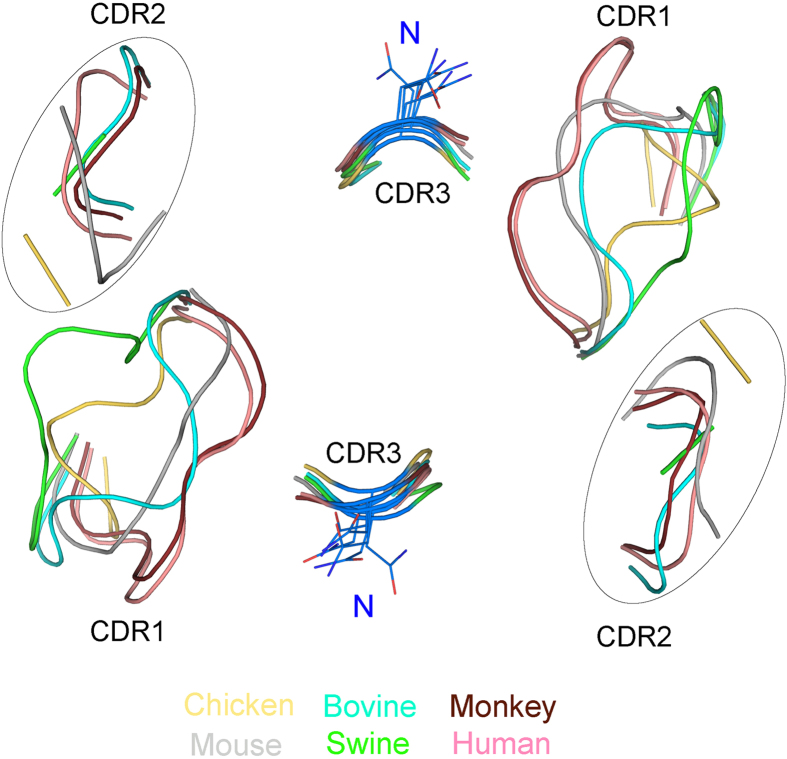
The diverse CDR1/2 and conserved CDR3 loops in CD8αα structures.The structural alignment shows the CDR-like loops of the six known CD8αα structures. Different colours consistent with those of the above figures were used to distinguish these six different CD8αα structures. The diverse CDR2-like loops were circled for clarity. The conserved residue N in the CDR3-like loop is shown in stick form.